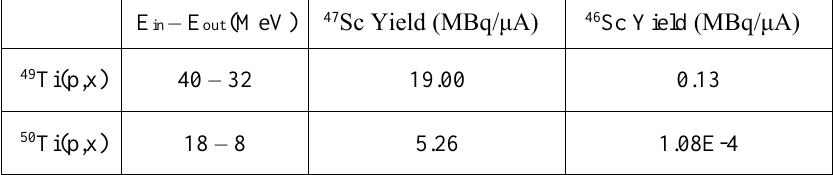
Table 1. 47 Sc and 46 Sc yields for both 49 Ti and 50 Ti targets. The irradiation parameters correspond to 1 μA current and 1 h irradiation